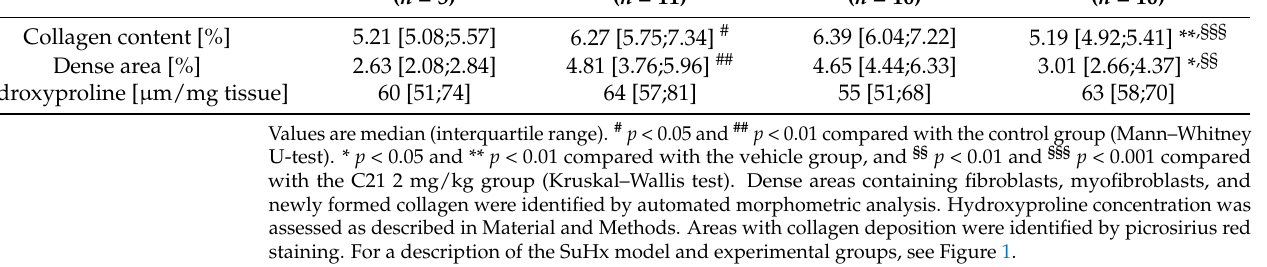
Table 1. Collagen, dense area, and hydroxyproline in the lungs of rats exposed to Sugen-hypoxia.